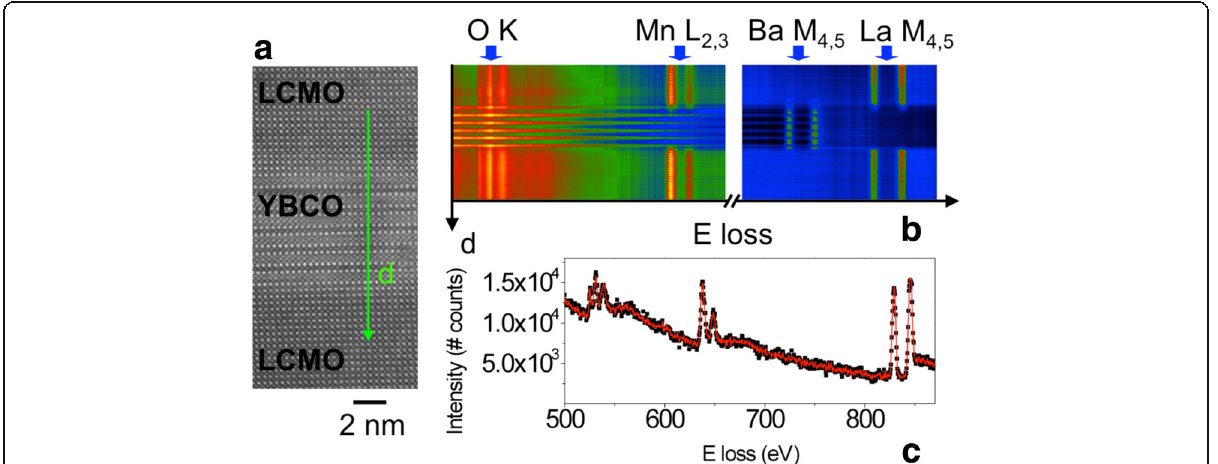
Fig. 13 High-resolution Z-contrast image of a LCMO/YBCO/LCMO trilayer, obtained at 100 kV. b EELS linescan acquired along the direction marked with an arrow in ( a ). Principal component analysis (PCA) has been used to remove random noise. c Sample spectrum extracted from the linescan in ( b ), acquisition time is 2 s per spectrum. The data points are a raw spectrum while the red line is the same dataset after PCA. Reproduced from Varela et al. 2012. Copyright 2012 Oxford University Press